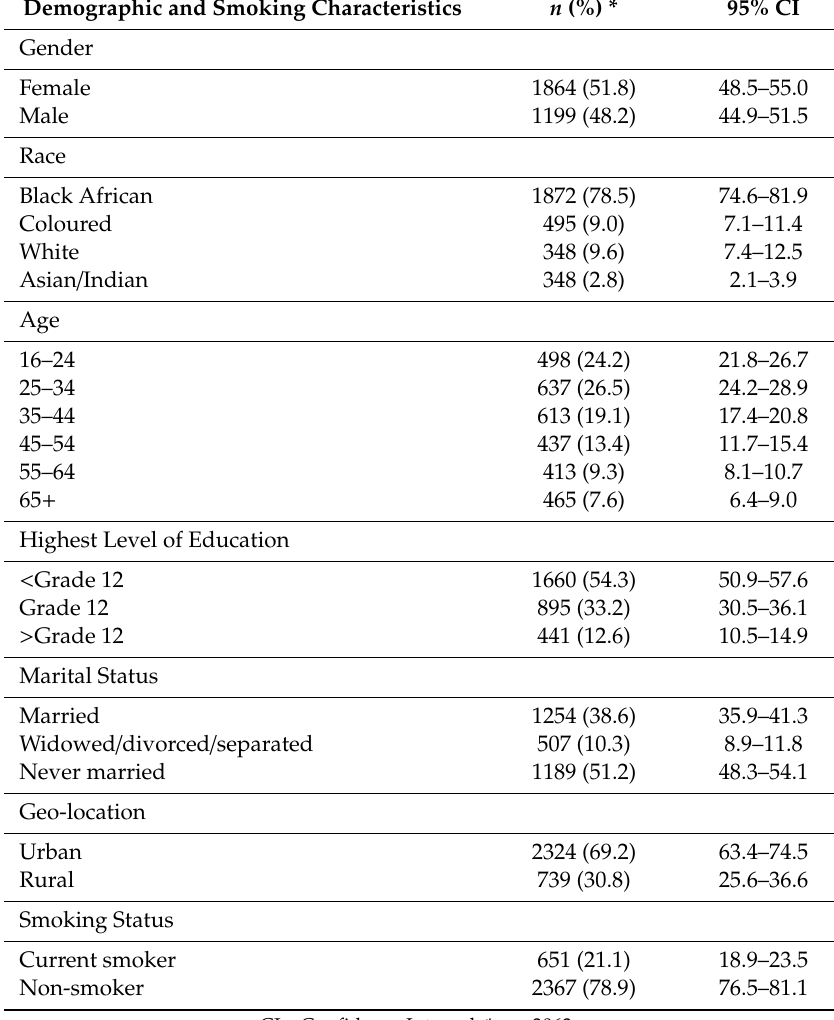
Table 1. Demographic characteristics and smoking status of